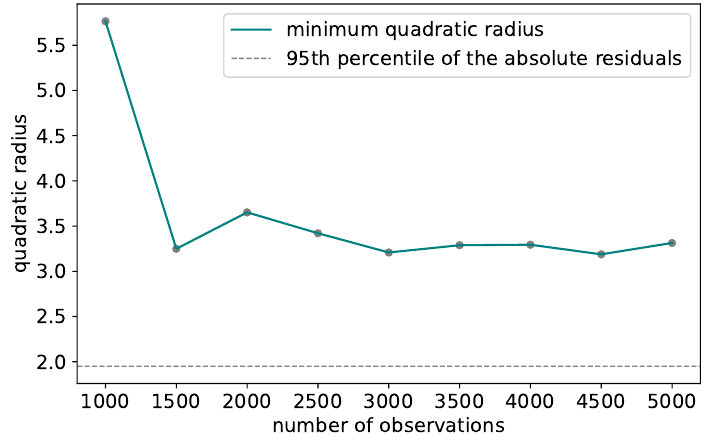
Figure 6 Minimal Radius of inferred quadratic region of the quantile Huber (solid line), compared to the 95% confidence region for residuals (dashed line), when errors are Gaussian with standard deviation 1. In every experiment, the quantile Huber framework infers a large κ value that pushes all residuals into the inlier region.